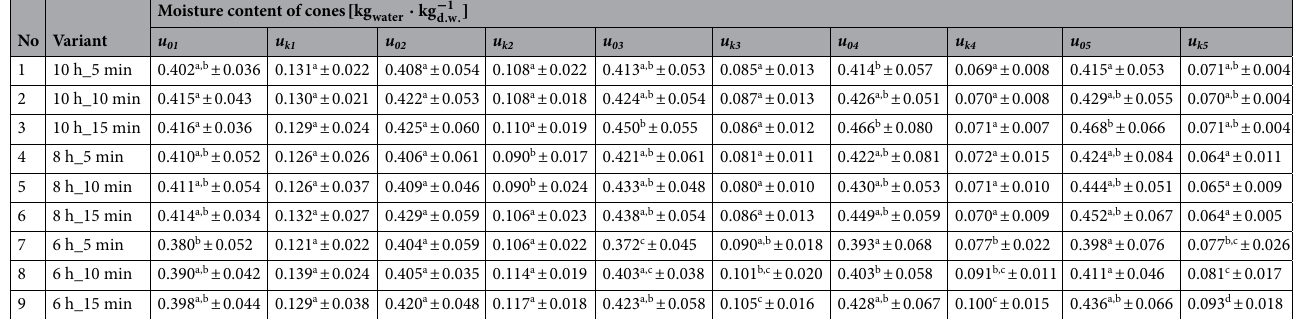
Moisture content of cones [ kg water · kg − 1 d.w. No Variant